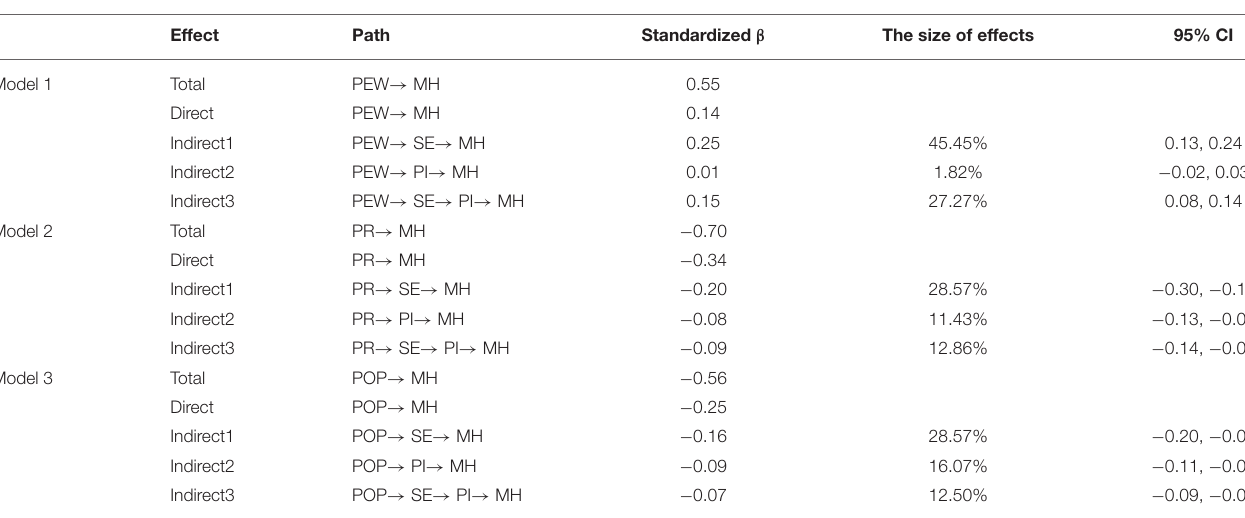
TABLE 3 | Bootstrap analysis of the mediating